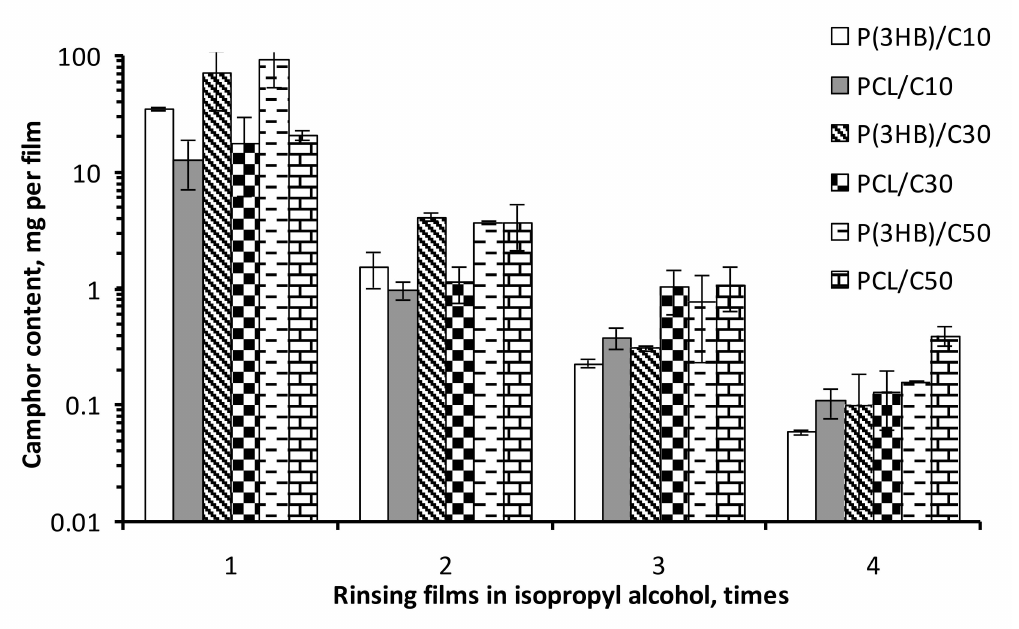
Figure 2. Camphor concentration decrease in the films rinsed in isopropyl alcohol four times.